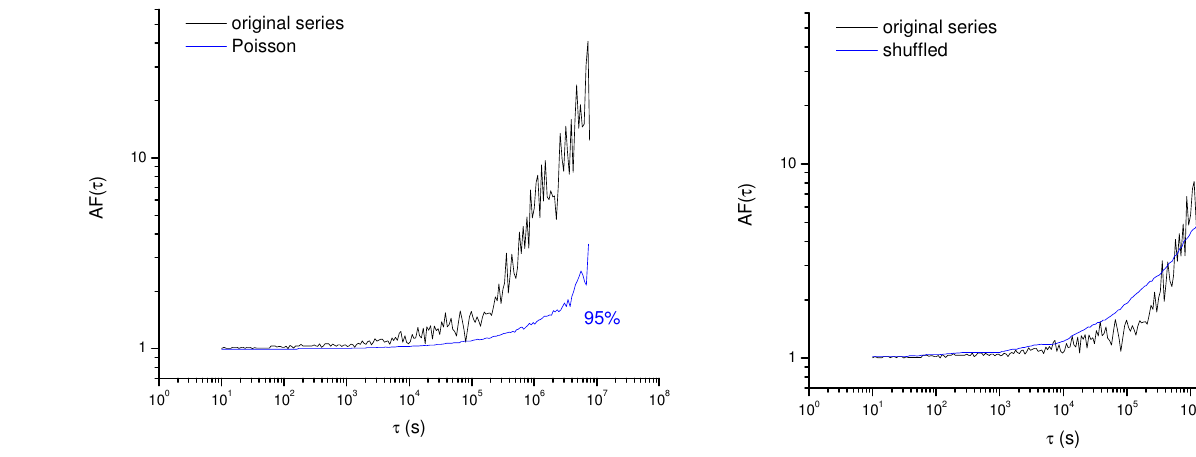
Fig. 9. Comparison between the AF of the cluster a and the 95% confidence curve evaluated over 1000 shuffled